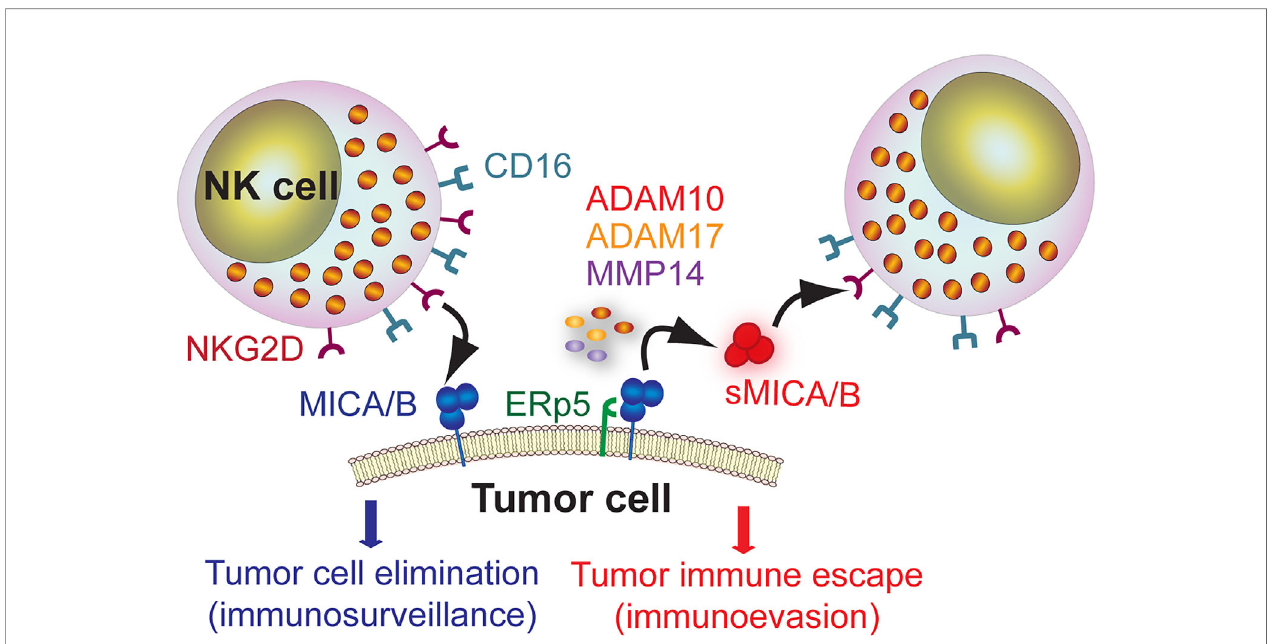
FIGURE 1 | Dual role of MICA/B as target molecule for immunosurveillance by NK cells and as mediator of tumor immune escape. MICA/B expressed on the cell surface of tumor cells can be recognized by NK cells through NKG2D and promote a cytotoxic response that leads to tumor cell elimination (immunosurveillance). However, MICA/B can associate with the ERp5 chaperone and, through a proteolytic cleavage mediated by ADAM10, ADAM17 and MMP14, generate sMICA/B that promote NKG2D down-regulation and impairment of NK cell-effector functions, thus facilitating tumor immune escape